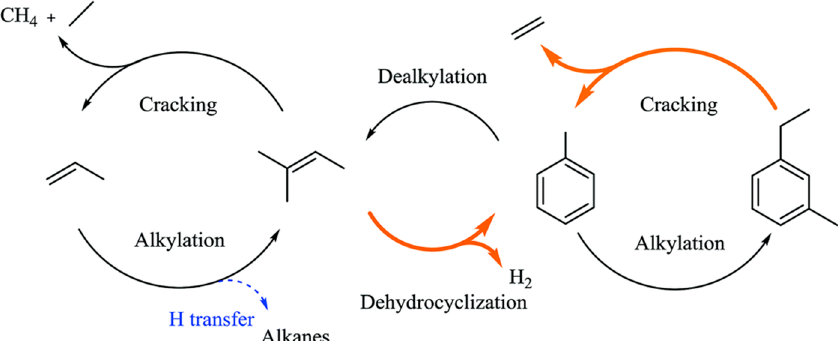
Figure 26. Proposed Ga role for ethanol conversion over Ga-ZSM-5: orange lines for promoted reactions and blue dashed line for suppressed reaction. Reprinted with permission from ref [49]. Copyright 2017 Royal Society of Chemistry.